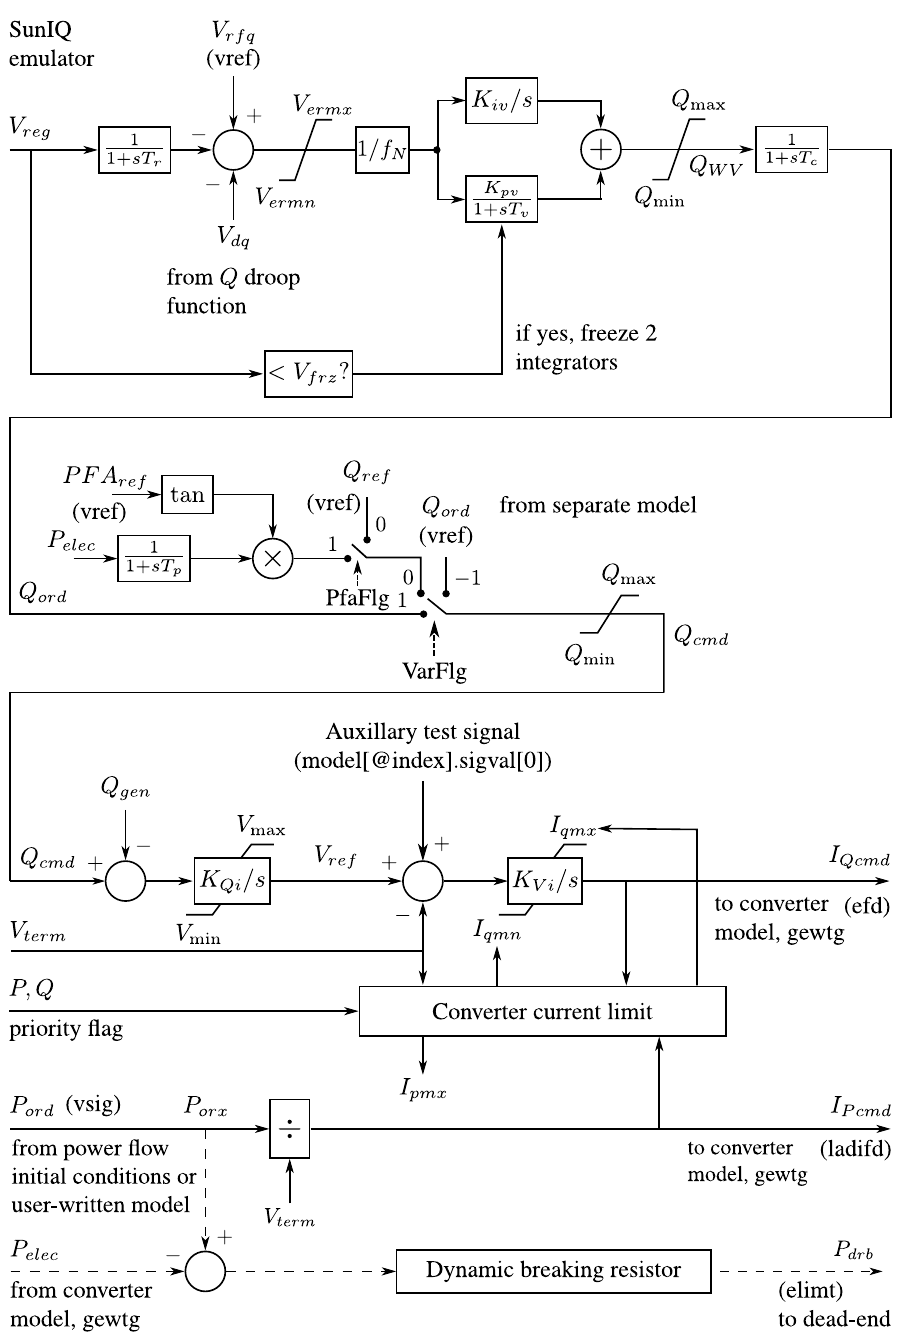
Figure 3. First-generation PV model: converter electrical